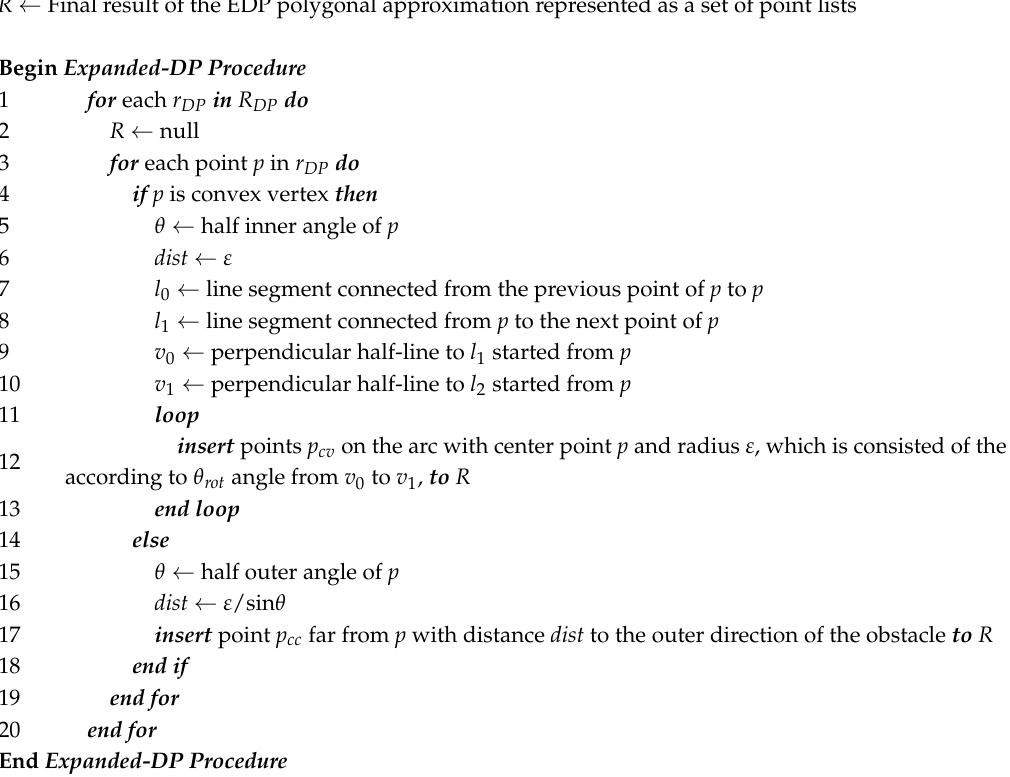
Algorithm 3. Pseudo Code of EDP (Abstract version).